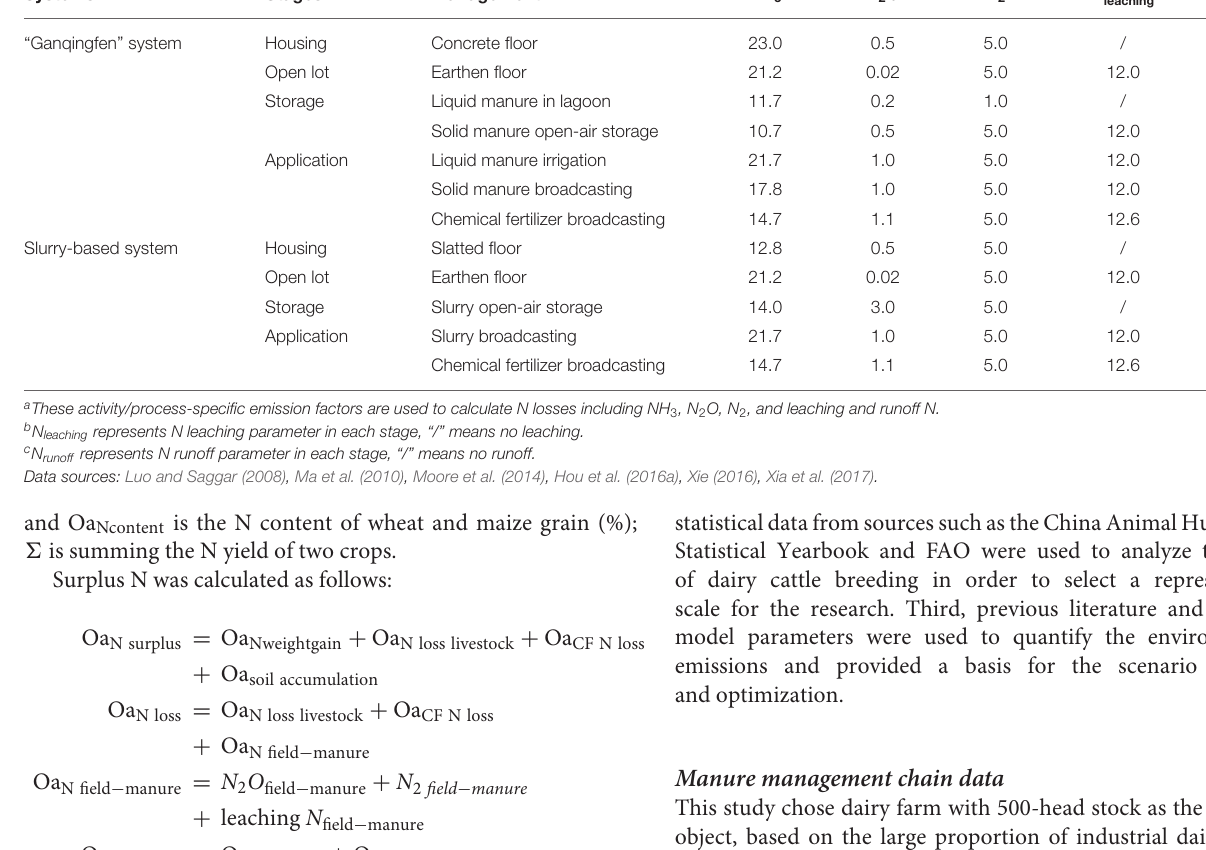
TABLE 1 | Parameters of various pathways of N losses at each manure management stages in reference systems (% of N) a .